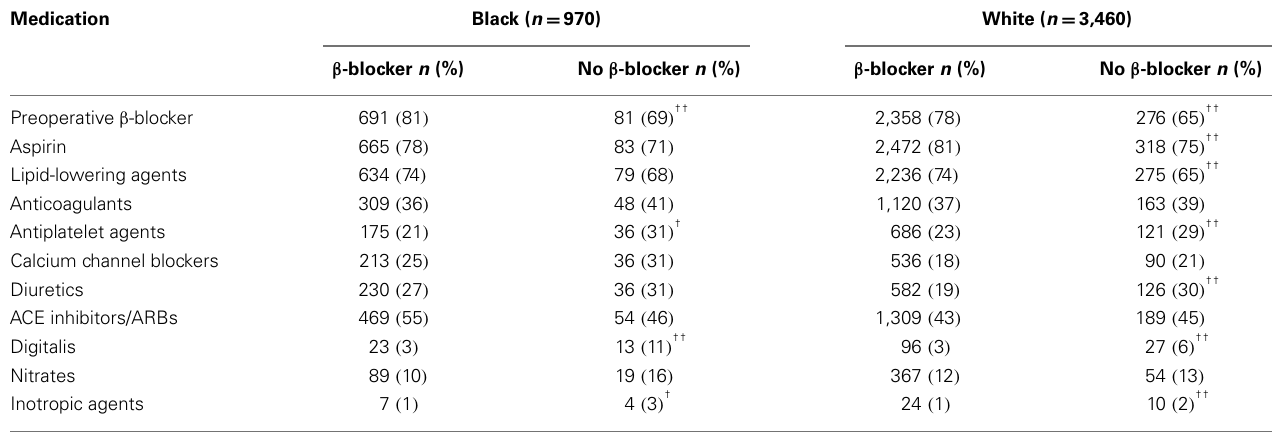
Table 2 | Preoperative medications